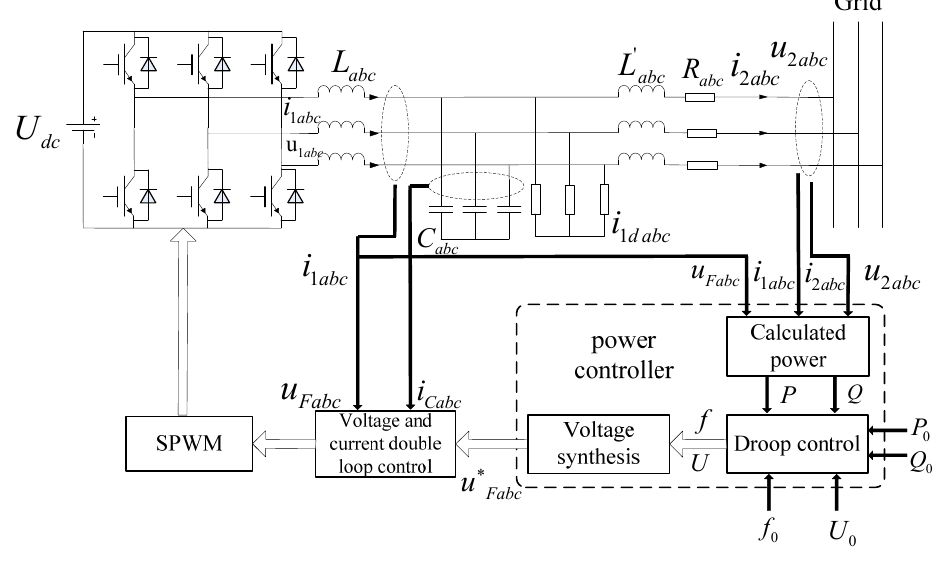
Figure 3. The control structure of the